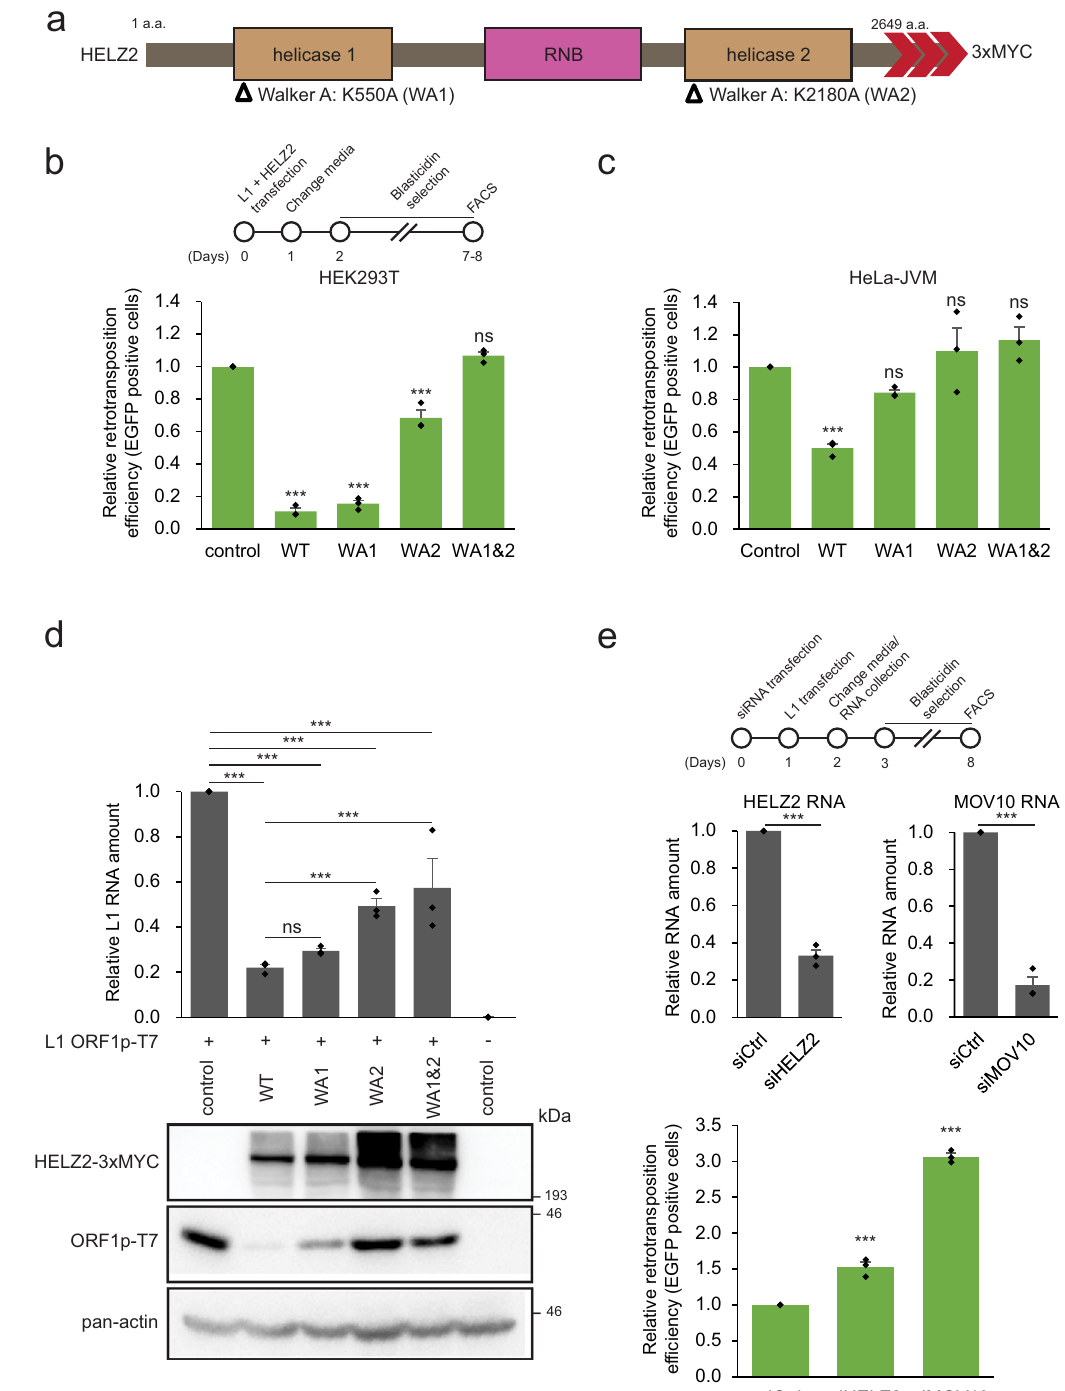
(Fig. 6e, L1 [ Δ 5 ′ UTR]; a.k.a. pTMF3_ Δ 5UTR). As an